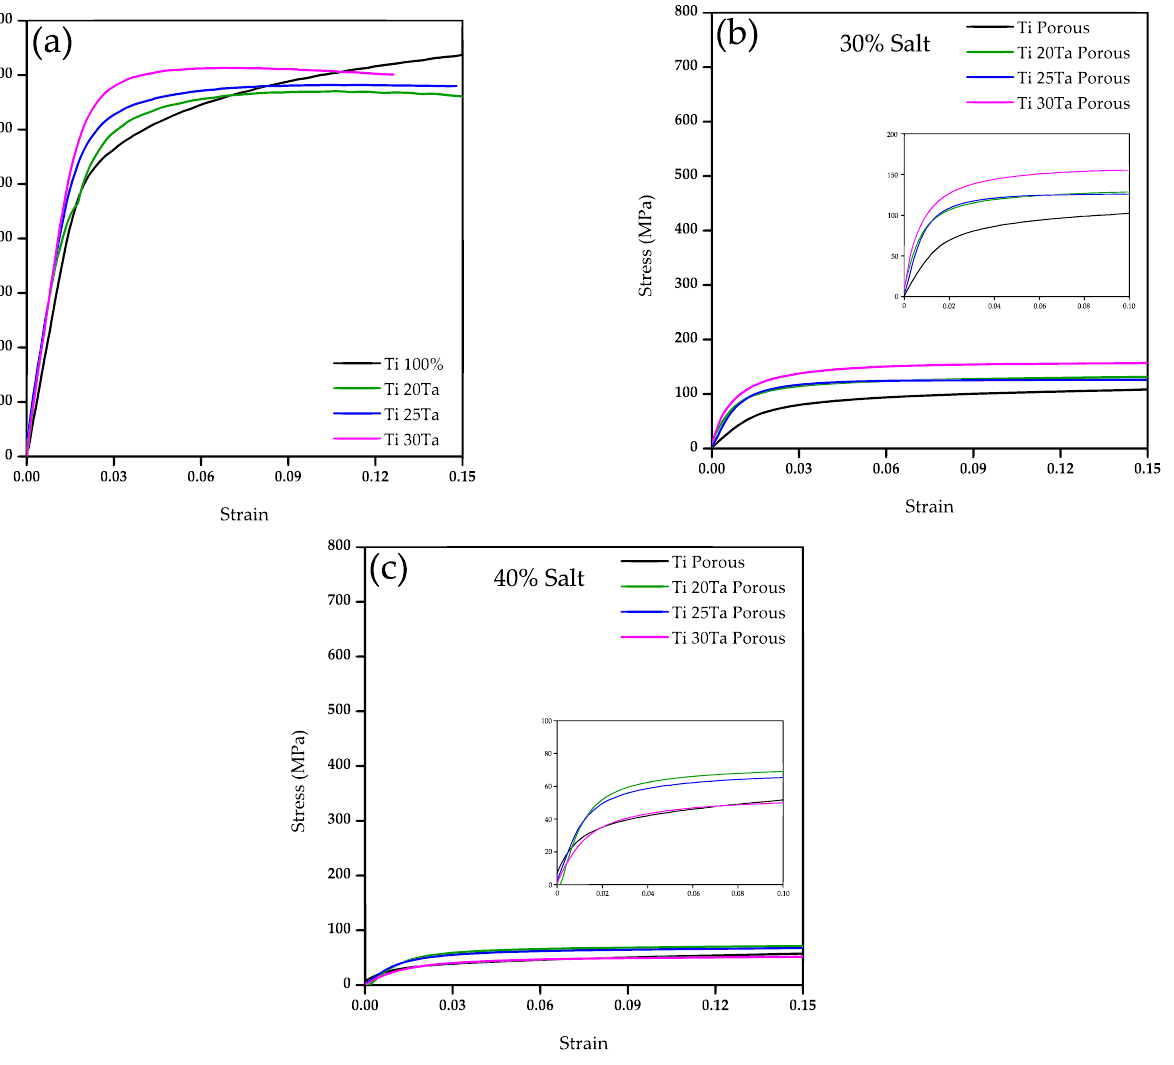
Figure 11. Stress-strain curves of samples sintered at 1260 °C, ( a ) Ti-xTa; ( b ) Ti-xTa with 30 vol.% of salt particles; and ( c ) Ti-xTa with 40 vol.% of salt particles.